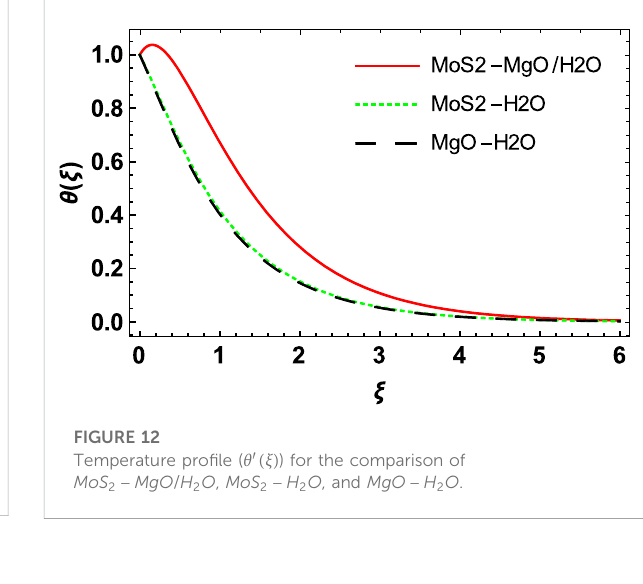
FIGURE 12 Temperature pro fi le ( θ ′ ( ξ ) ) for the comparison of